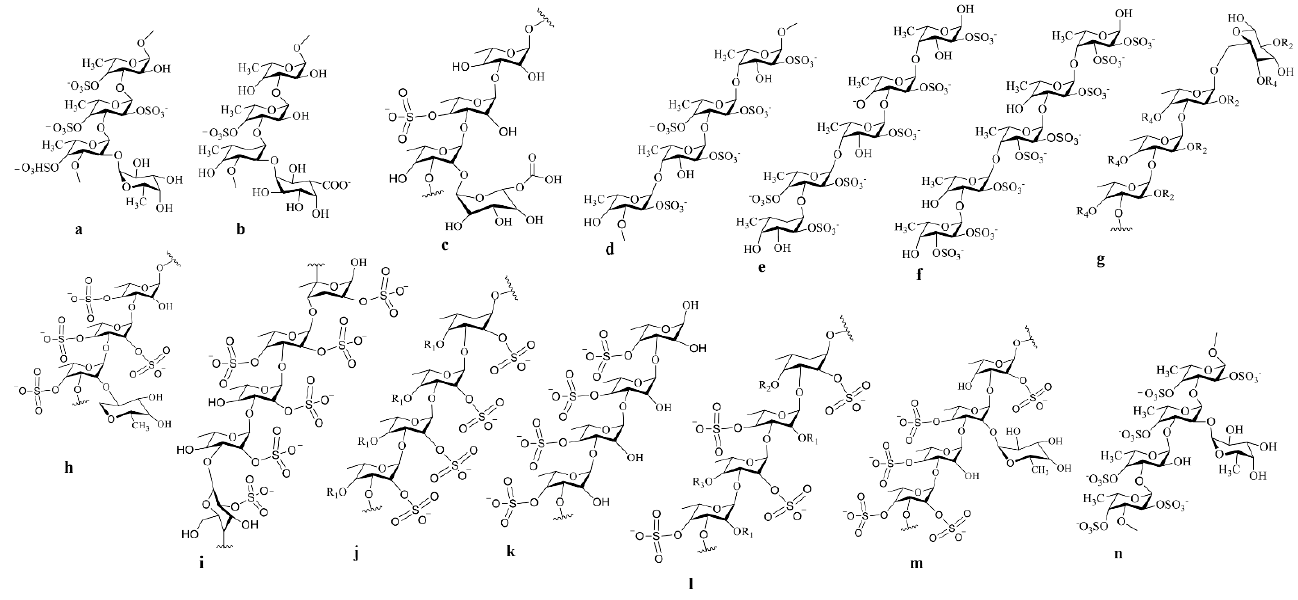
Figure 3. The Molecular structure of different types of sulfated polysaccharides such as fucoidan, with potential therapeutic effects, are drawn in Chemdraw 12.0 Ultra. The different fucoidan structures derived from different brown seaweeds such as Laminaria saccharina ( a ); Cladosiphon okamuranus ( b ); Cladosiphon okamuranus ( c ); Fucas evanescens ( d ); Fucas serratus ( e ); Ascophyllum nodosum/ F. vesiculosus ( f ); Sargassum mcclurei ( g ); Laminaria saccharina ( h ); Turbinaria conoides ( i ); Sargassum cichorioides ( j ); Turbinaria ornata ( k ); Undaria pinnatifida ( l ); Chorda filum ( m ); and Chorda filum ( n ). Fucoidan from F. vesiculosus induced apoptosis in cancer cell lines including NB4,